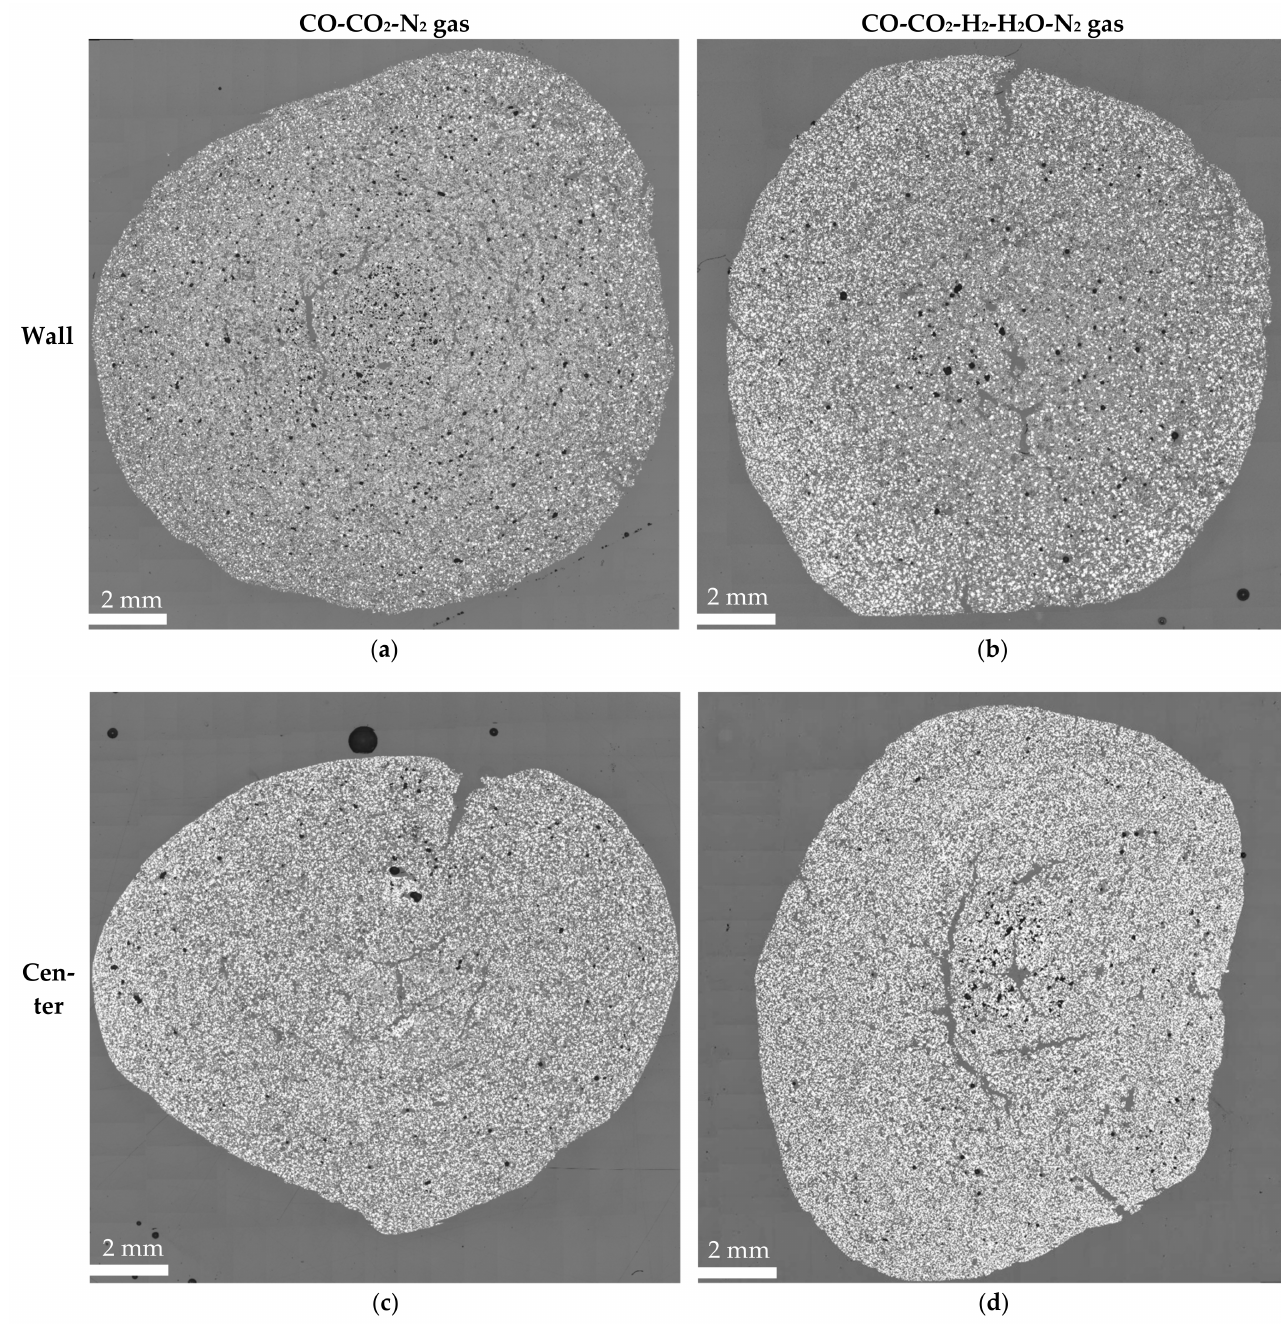
Figure 10. Pellet cross-sections after isothermal reduction at 1000 ◦ C, using ( a ) the wall profile in CO-CO 2 -N 2 gas, ( b ) the wall profile in CO-CO 2 -H 2 -H 2 O-N 2 gas, ( c ) the center profile in CO-CO 2 -N 2 gas, and ( d ) the center profile in CO-CO 2 -H 2 -H 2 O-N 2